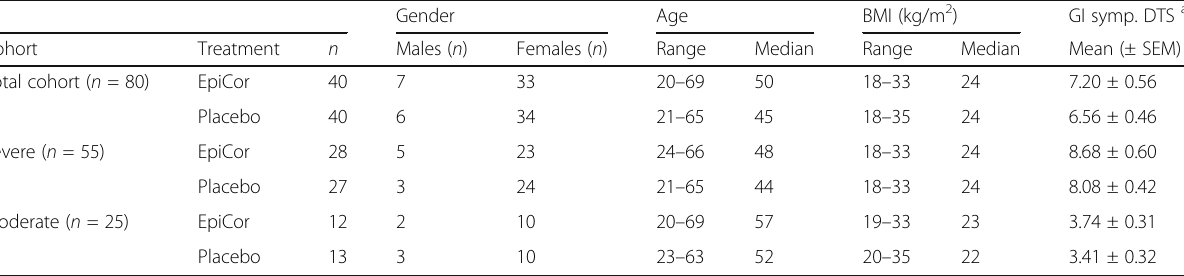
Table 3 Subjects allocation per trial arm and subgroup and baseline characteristics Gender Age BMI (kg/m 2